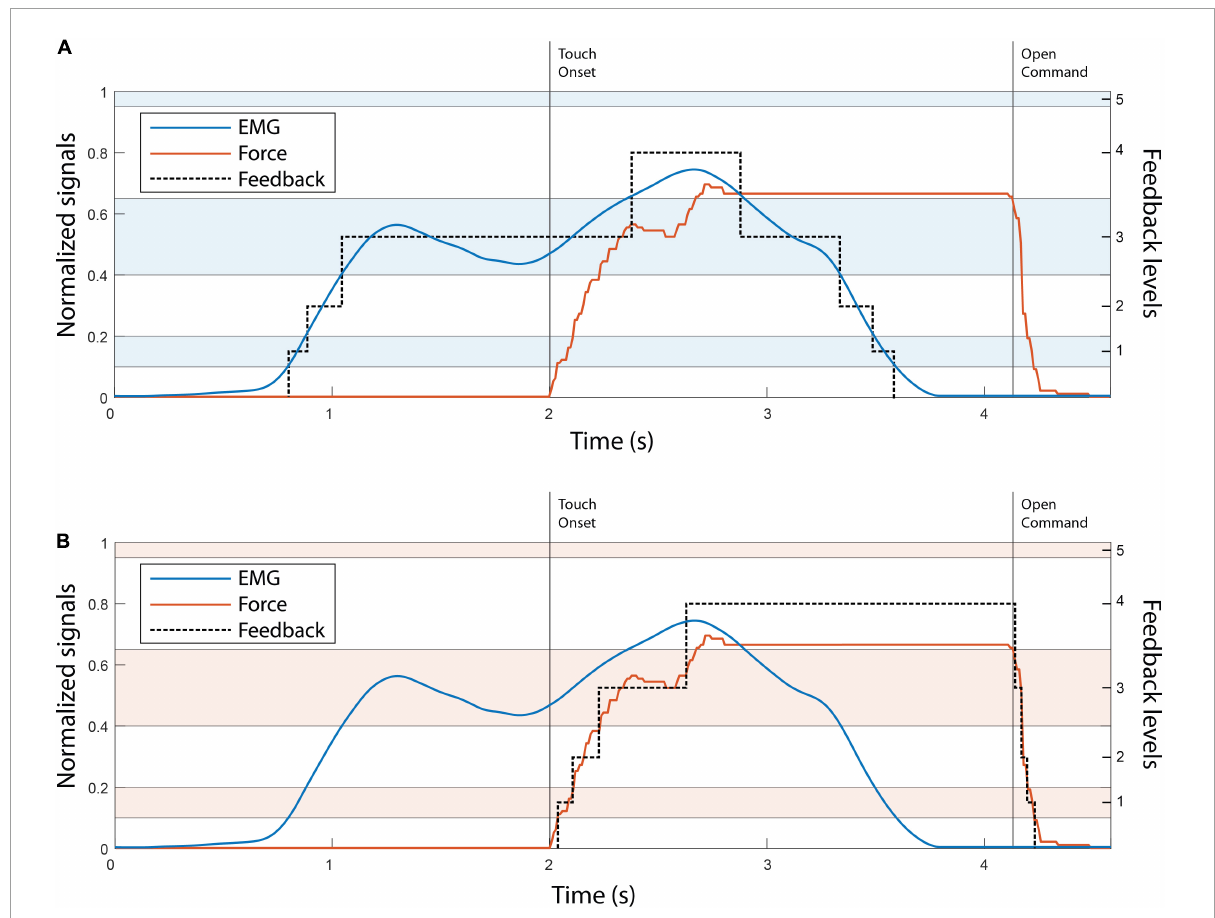
FIGURE3 The illustration of EMG (A) and force (B) feedback. The EMG and force traces in both panels A, B are denoted with blue and red, respectively. The black dotted line in both plots indicates the feedback level. The alternating color bands are the EMG and force ranges. The touch onset and the moment that the open command was sent to the hand are denoted with vertical black lines. Note that levels 1–4 are of progressively larger size, to account for the higher EMG variability in stronger